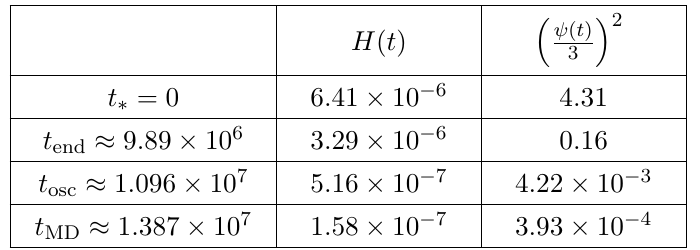
(cid:16) (cid:17) 2 at the beginning and end of in(cid:13)ation, and at the beginning 3